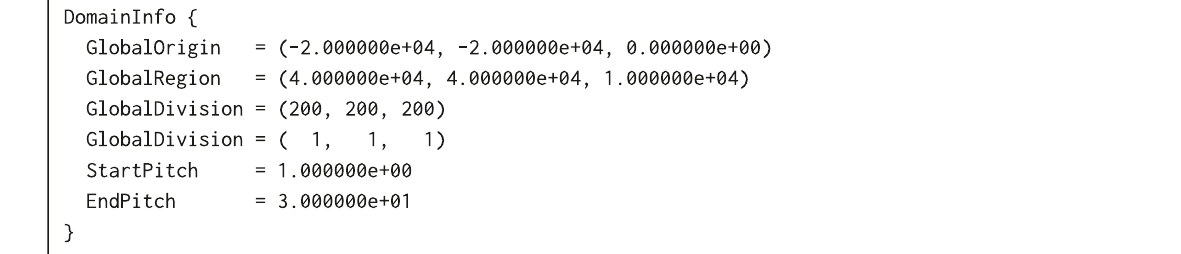
Figure 6: Extracted mesh parameters. GlobalOrigin and GlobalRegion give information on the computational region, GlobalDivision is the number of divisions in the X , Y , and Z directions, and StartPitch and EndPitch represent the spacings of the two ends of line segments,